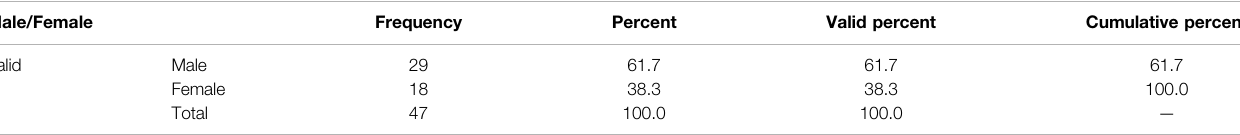
TABLE 2 | Frequency of study